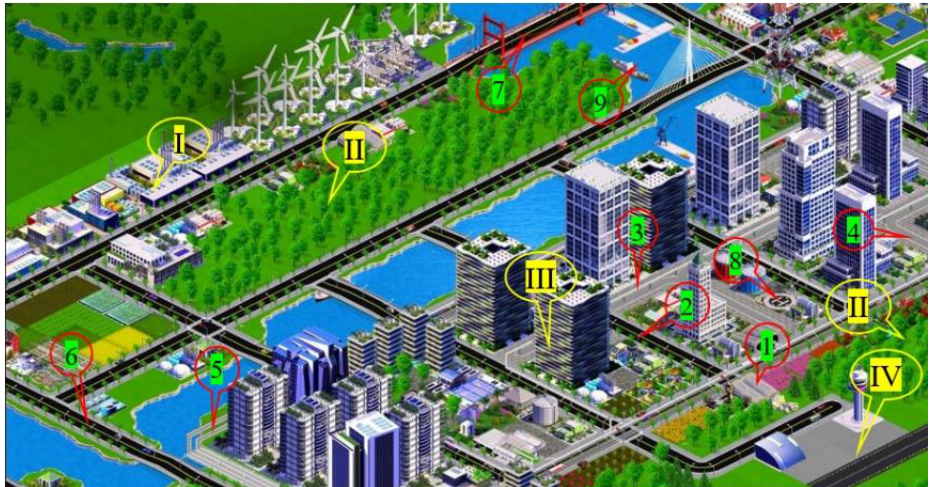
Figure 14. Urban total transportation system: I — industrial area (factories), II — Forest area, III — urban area, IV — airport area, 1 — underground, 2 — road, 3 — upper ground, 4 — path, 5 — railway, 6 — highway, 7 — freight transport, 8 — urban air transport, 9 — water transport.